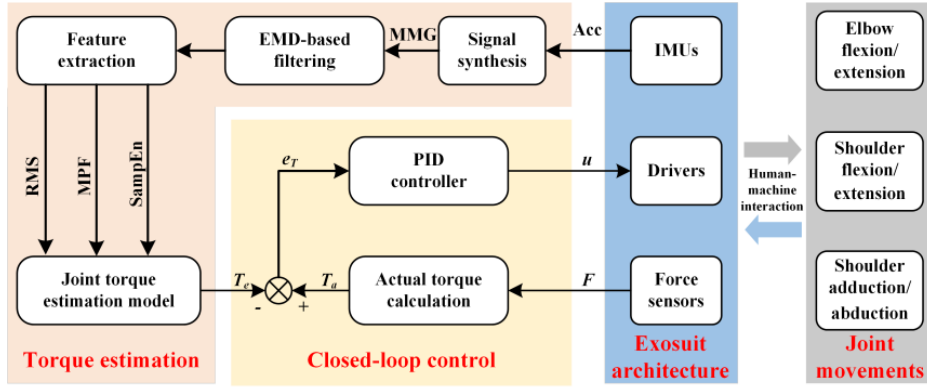
Figure 8. Torque estimation-based control strategy.